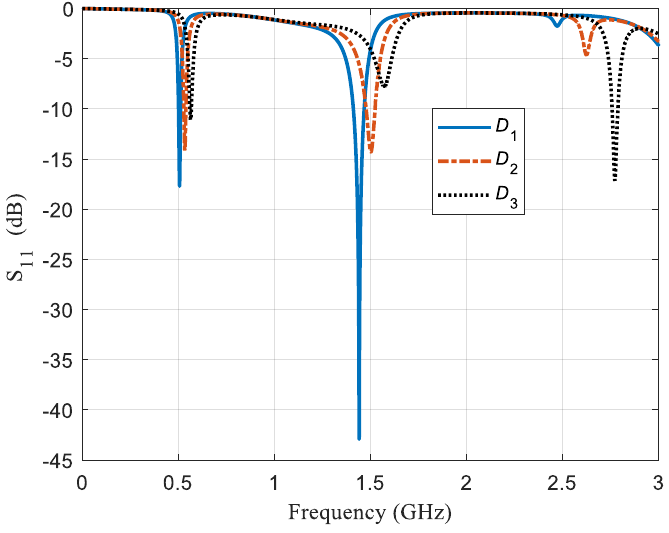
Figure 2. Reflection losses as a function of frequency of the rectangular resonator for three different configurations ( D 1 , D 2 , and D 3 ). This frequency range shows the three first modes N of a resonator at ~0.5 GHz for the first mode, at ~1.5 GHz for the second mode, and at ~2.6 GHz for the third mode. Even though it is the same resonator and modes, reflection loss values are quite differ- ent.